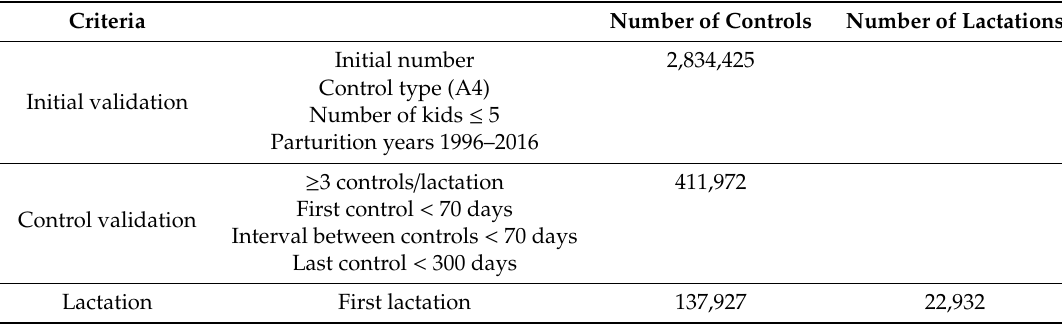
Table 1. Data exclusion criteria.